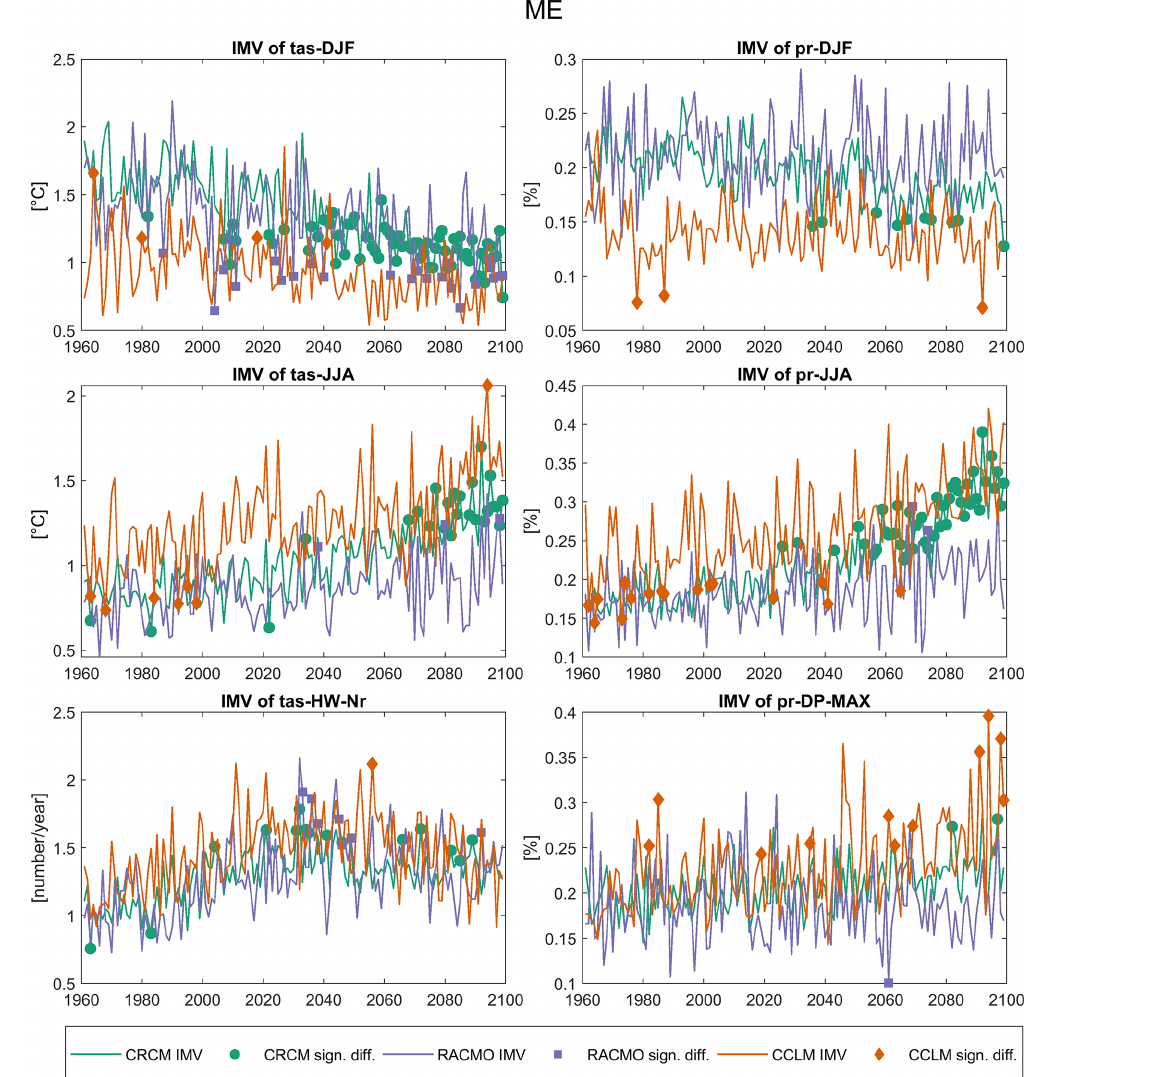
Figure 9. IMV per year sampled on the dimension of the respective ensemble size (50, 21 and 16) for mid-Europe. The analysis is based on residuals after removing the EM from each member. The markers highlight years with a significantly different variance than the reference year 1961. Precipitation-based indicators are shown with their relative anomalies from the ensemble mean